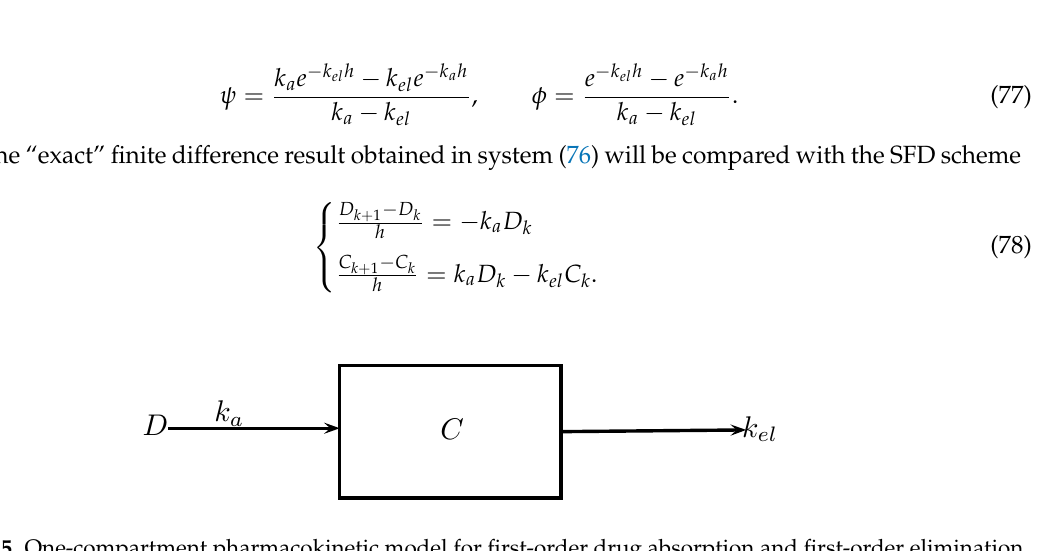
Figure 5. One-compartment pharmacokinetic model for first-order drug absorption and first-order elimination.